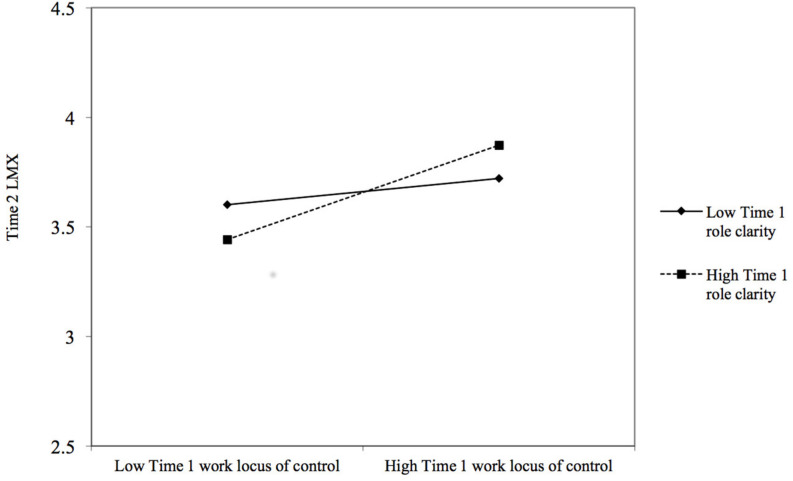
Interaction between Time 1 work locus of control and Time 1 role clarity predicting Time 2 leader–member exchange (LMX), controlling for Time 1 LMX. Relationships are shown at 1 SD above and below the mean of Time 1 role clarity.